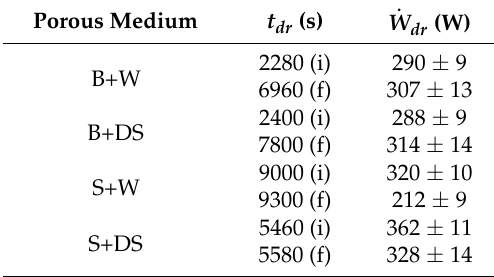
Table 8. Thermal power values corresponding to the beginning of the dryout (i) and the total dryout state